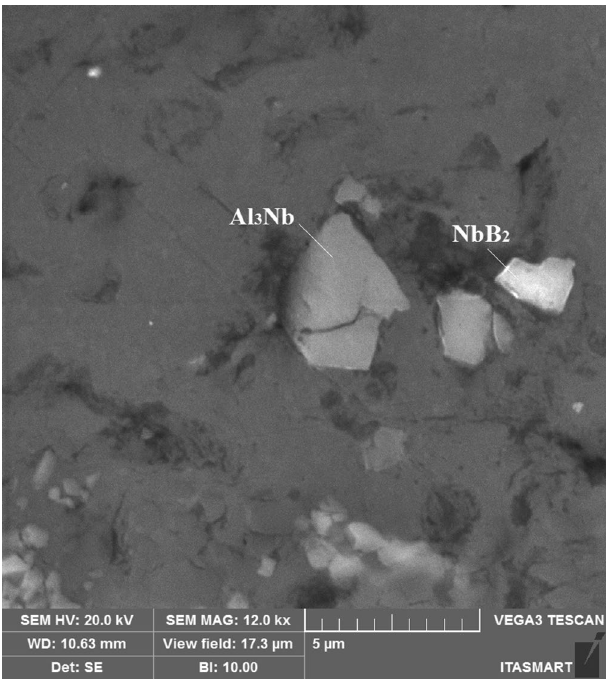
Figure 2. Al 3 Nb and NbB 2 substrates identified in the scanning electron microscope (SEM), with a detector analyser (SEM–EDS), present in the core of the primary α-Al grain, found in the Al7Si1Fe alloy, with the addition of 0.5%